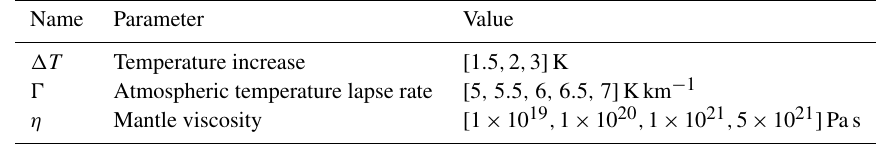
Table 1. Parameters used in experiments.